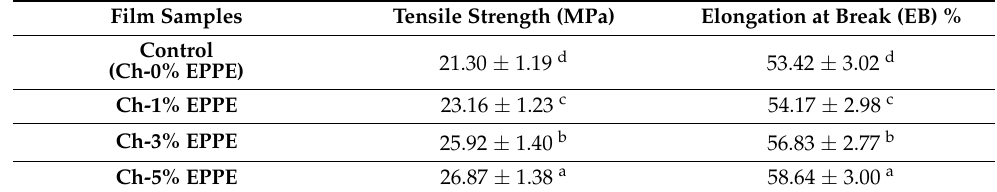
Table 3. Mechanical properties of chitosan films modified with different percentages of